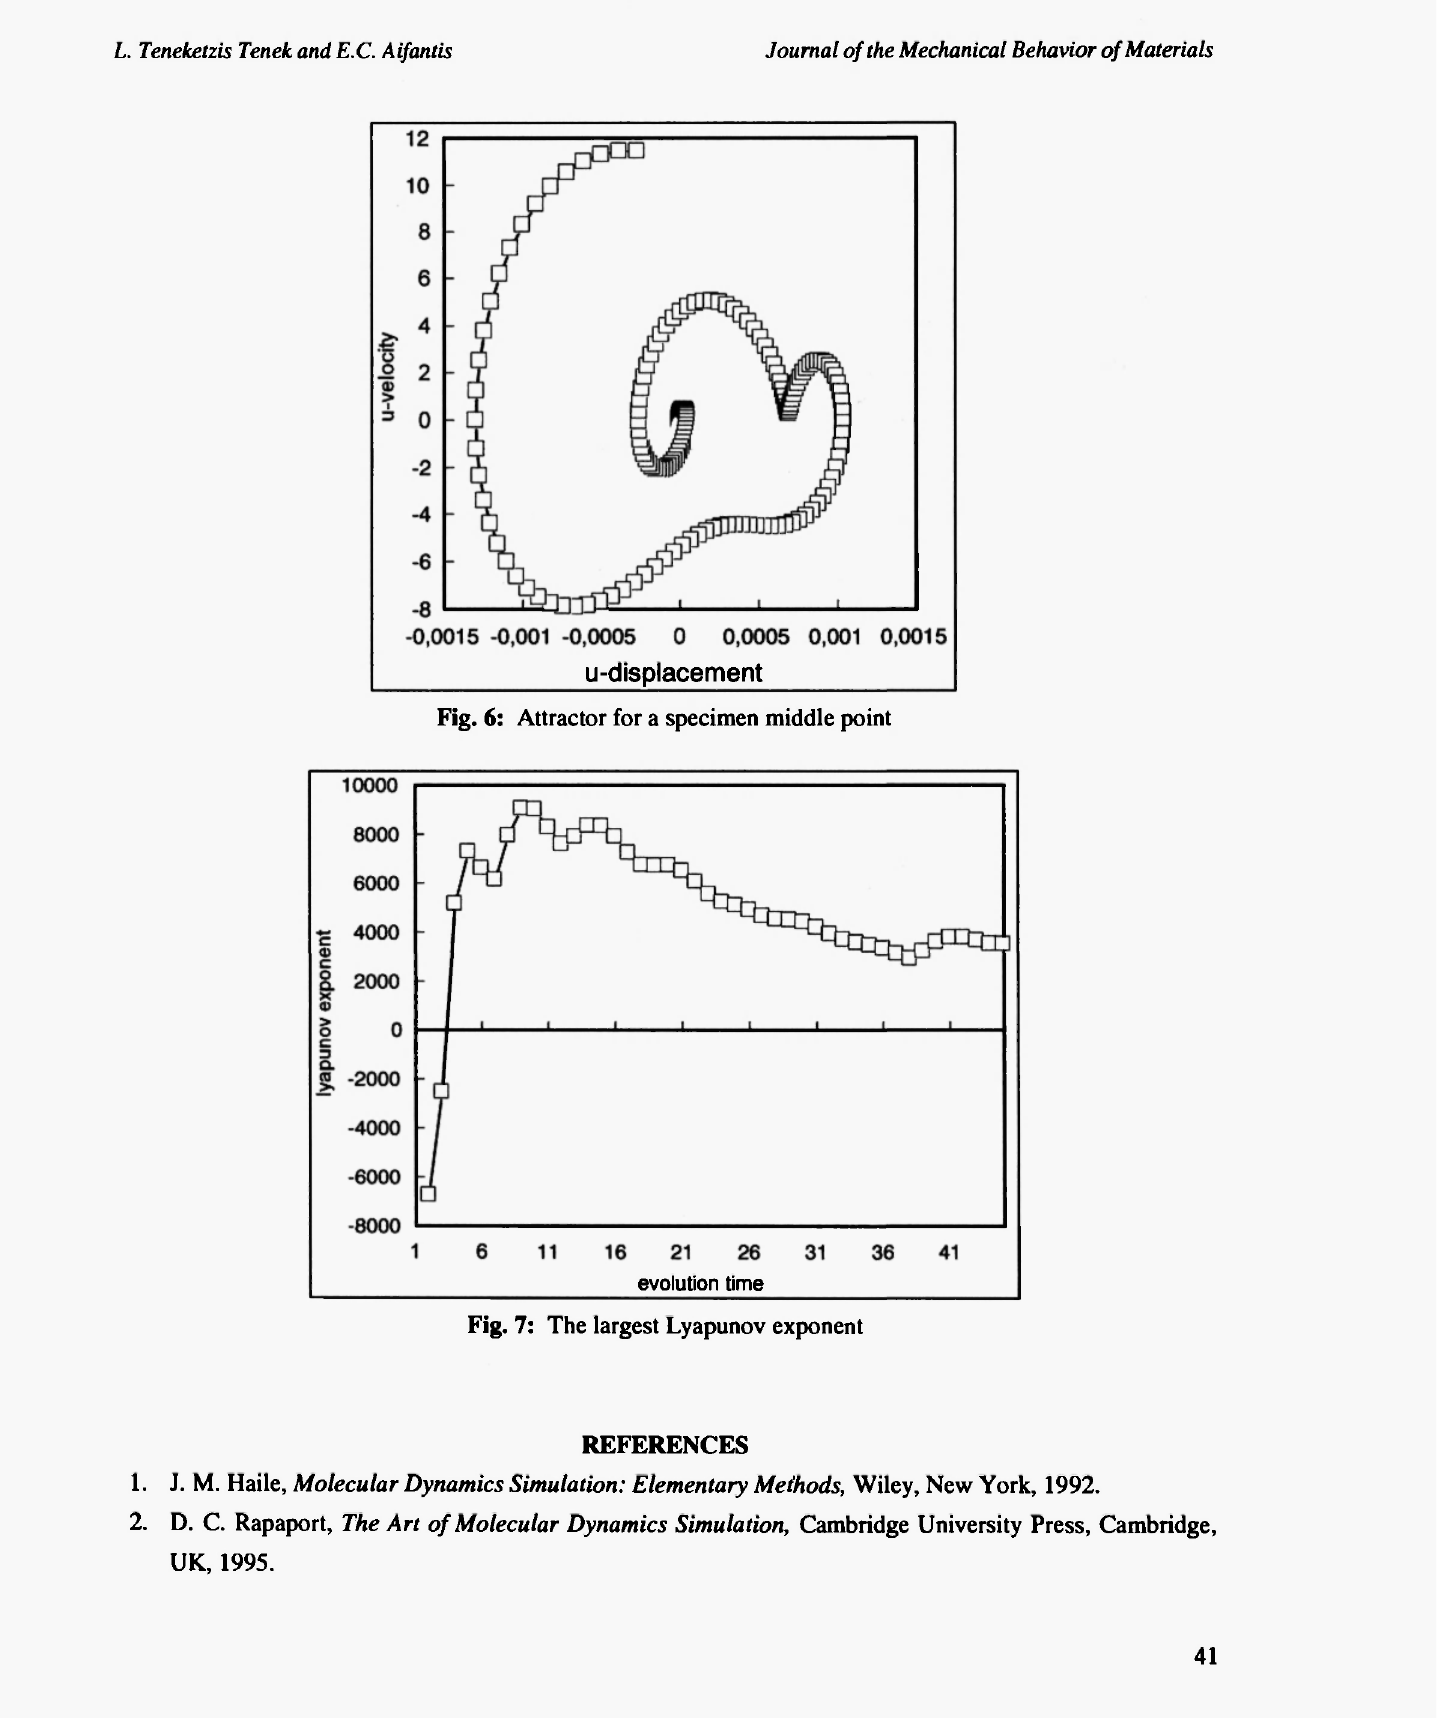
Fig. 7: The largest Lyapunov